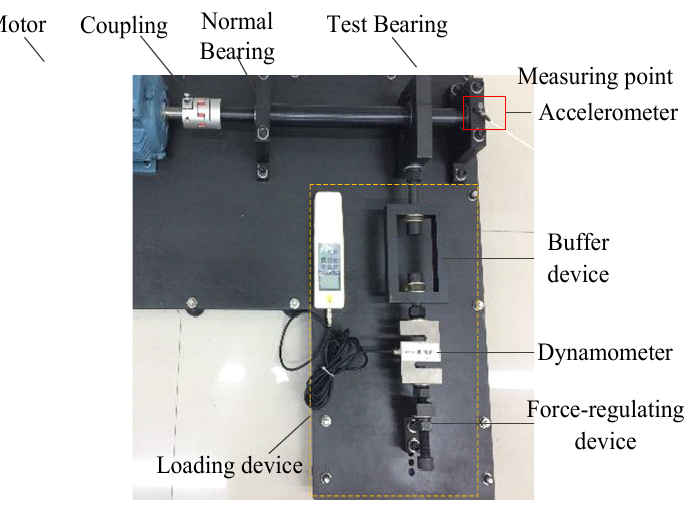
Figure 6. Bearing fault diagnosis model based on an improved CDBN.